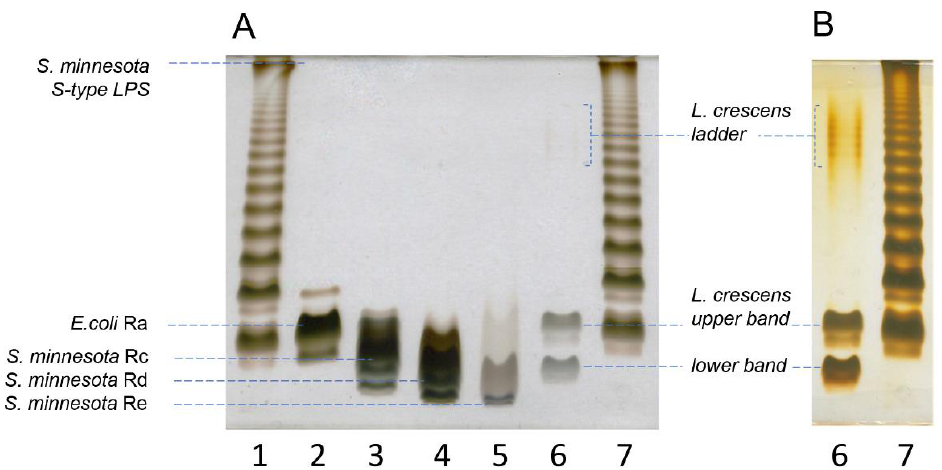
Figure 1. Comparative DOC-PAGE analysis of the LPS from Lcr. Panel ( A ): LPS from Lcr (Lane 6, 0.5 µg) was run alongside LPS of Salmonella enterica serovar Minnesota S-strain LPS (Lanes 1 and 7, 2 µg); E. coli EH100 (Ra mutant) (Lane 2, 0.5 µg), S. minnesota R5 (Rc mutant) (Lane 3, 0.5 µg), S. minnesota R7 (Rd mutant) (Lane 4, 0.5 µg) and S. minnesota R595 (Re mutant) (Lane 5, 0.5 µg). Panel ( B ): Overexposure of the gel to silver staining allowed for viewing of the faint higher molecular weight bands from Lcr LPS.